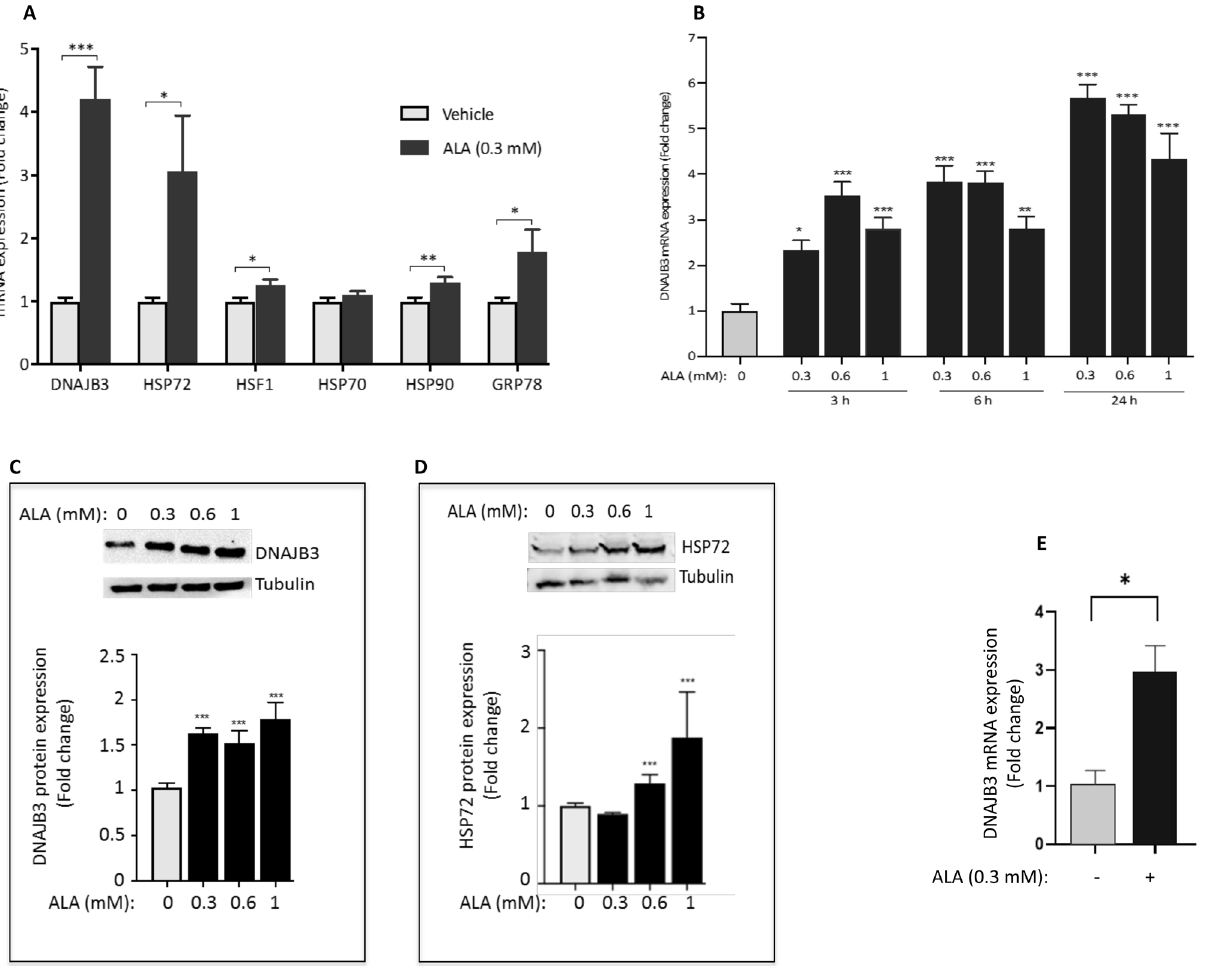
Figure 1. Alpha lipoic acid (ALA) induces the endogenous expression of DNAJB3 in C2C12 and HepG2 cells. ( A ) RT-PCR data showing the effect of 0.3 mM ALA for 24 h on the expression of representative components of the heat shock response in C2C12 cells. ( B ) Dose and time effects of ALA on the expression of DNAJB3 mRNA in C2C12 cells. Western blots confirming the positive effect of 24 h treatment with ALA on the expression of DNAJB3 ( C ) and HSP72 ( D ) proteins in C2C12 cells. Full-length blots are displayed in Supplementary Fig. S1. ( E ) ALA at 0.3 mM for 24 h also increases the expression of DNAJB3 mRNA in HepG2 cells. Ethanol was used at 0.25% as a vehicle. After performing Shapiro–Wilk normality test, t test was used to compare the difference between ALA and vehicle. NS not significant; *P < 0.05; **P < 0.01; ***P <